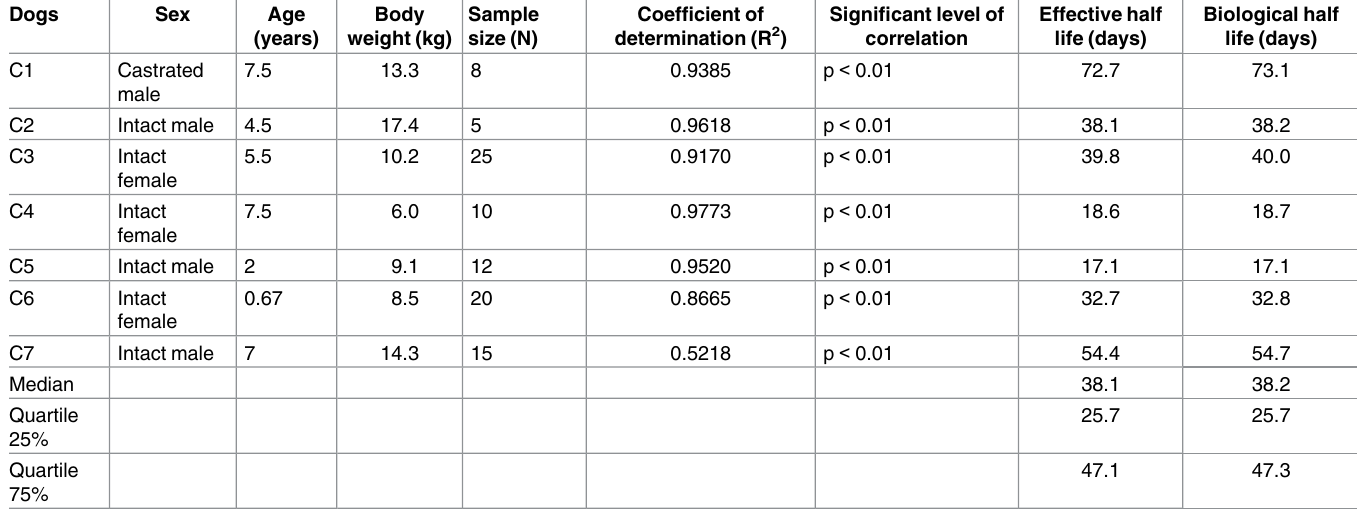
Table 1. 137 Cs biological half-lives and parameters of the decay curves of radiocesium in canine bodies. Dogs